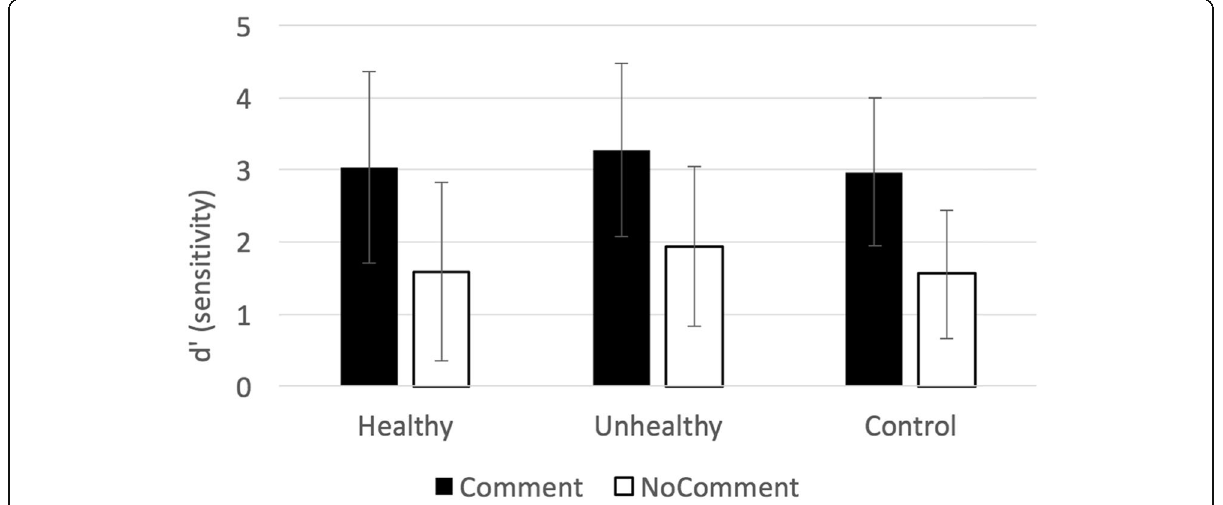
Fig. 1 Experiment 1: Illustration of memory sensitivity ( d ′ ) by condition. Error bars indicate by-participant standard